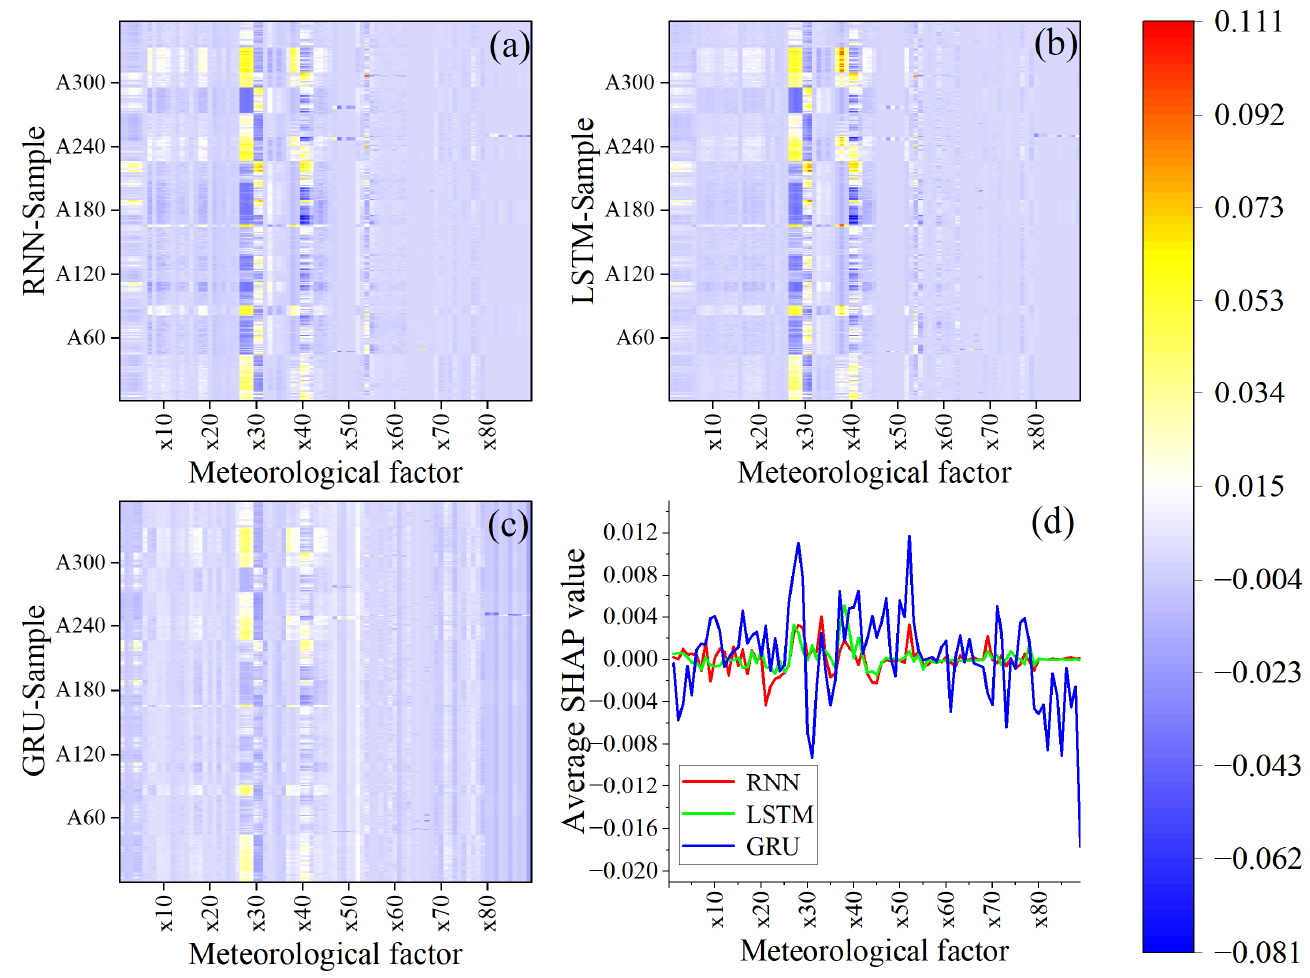
Figure 6. SHAP analysis figure of deep learning models ( a ). RNN contribution analysis thermody- namic diagram; ( b ). LSTM contribution analysis thermodynamic diagram; ( c ). GRU contribution analysis thermodynamic diagram; ( d ). Analysis figure of average contribution of each factor.